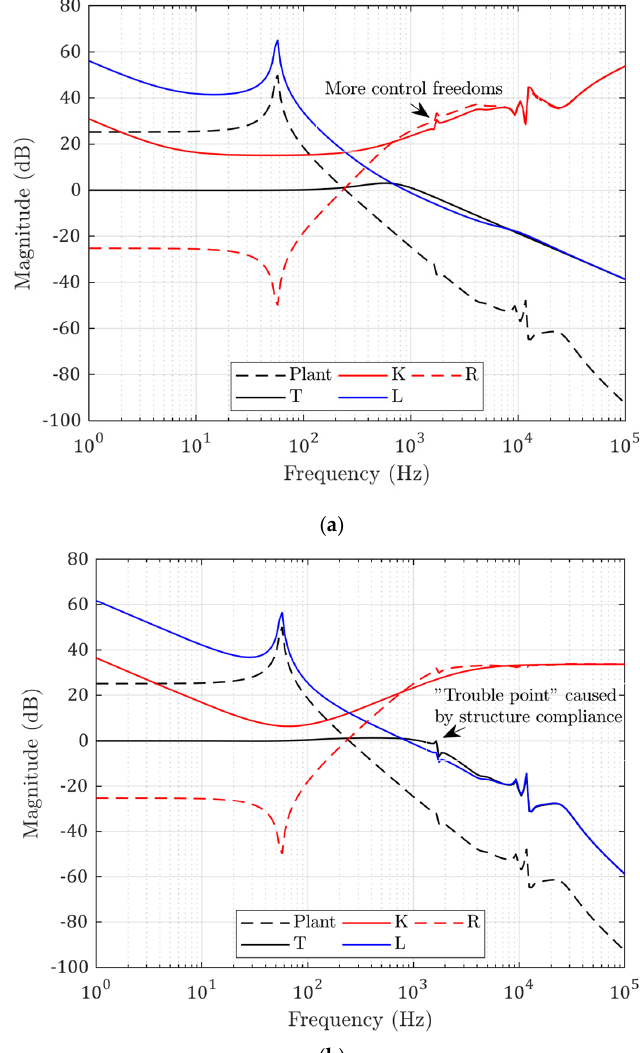
Figure 6. ( a ) Calculated optimal controller and transfer functions; ( b ) controller and transfer functions with PID control.